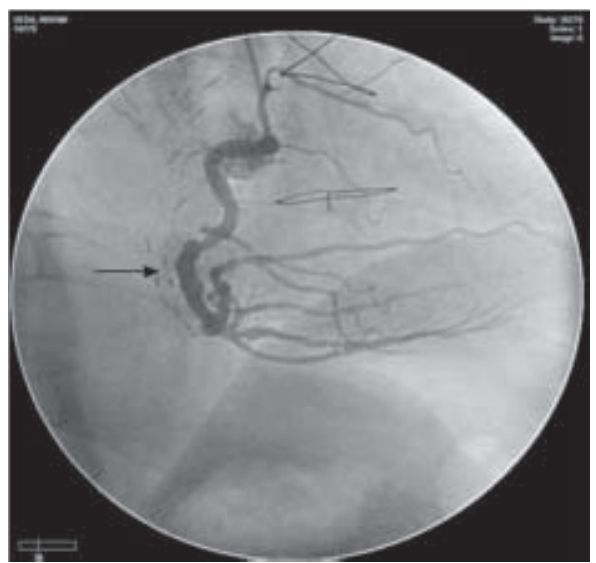
Fig. 3b - late restudy - 54 months after myocardial revascularization (RA